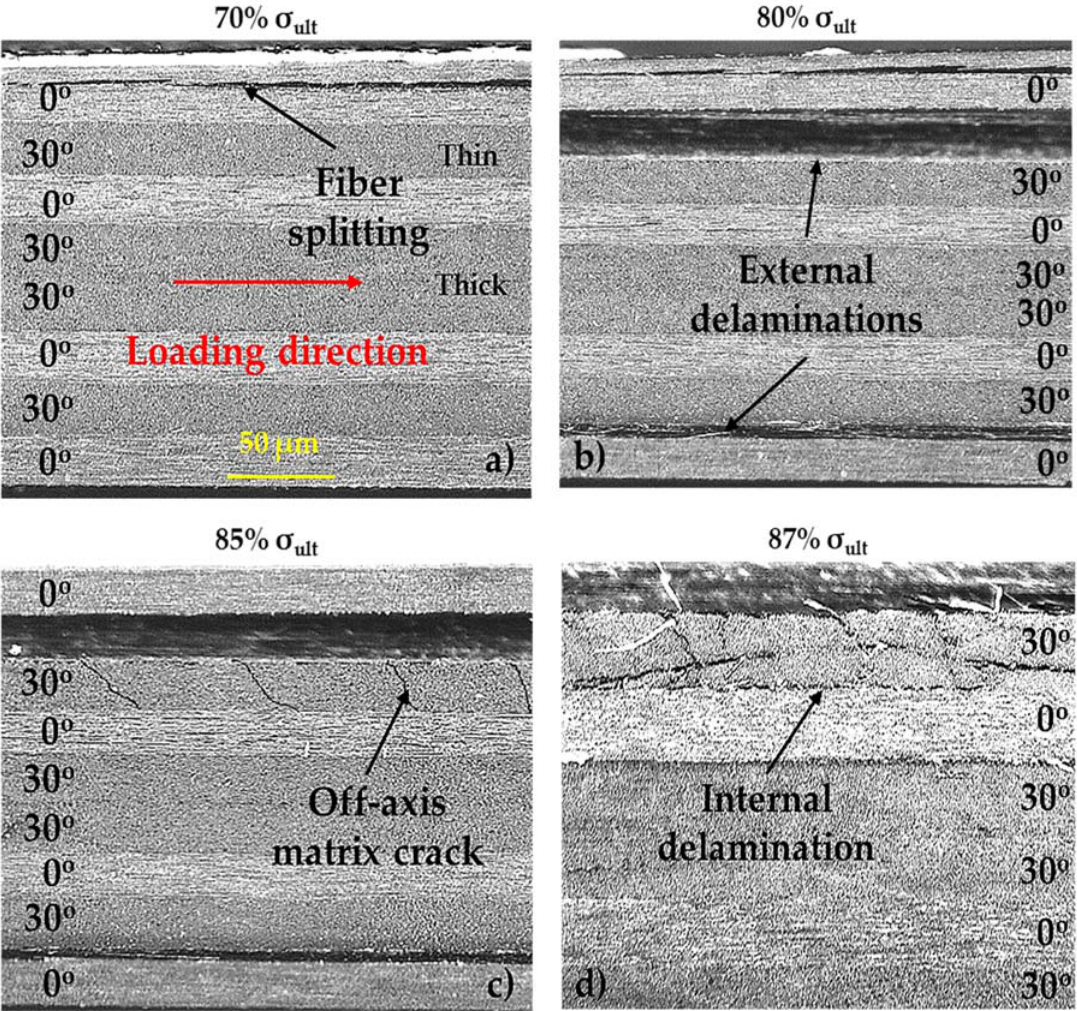
Figure 4. Damage state of [0°/30°] 2s laminates at ( a ) 70%, ( b ) 80%, ( c ) 85%, and ( d ) 87% of σ ult .